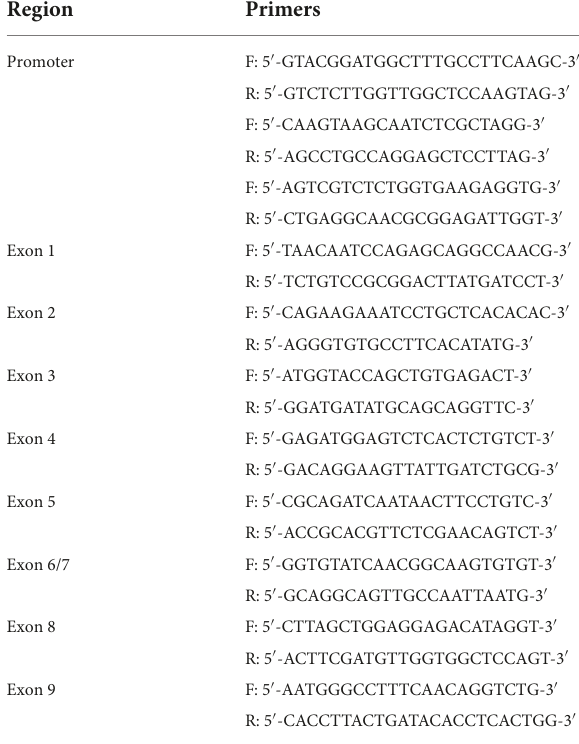
TABLE 1 Primers used in the re-sequencing